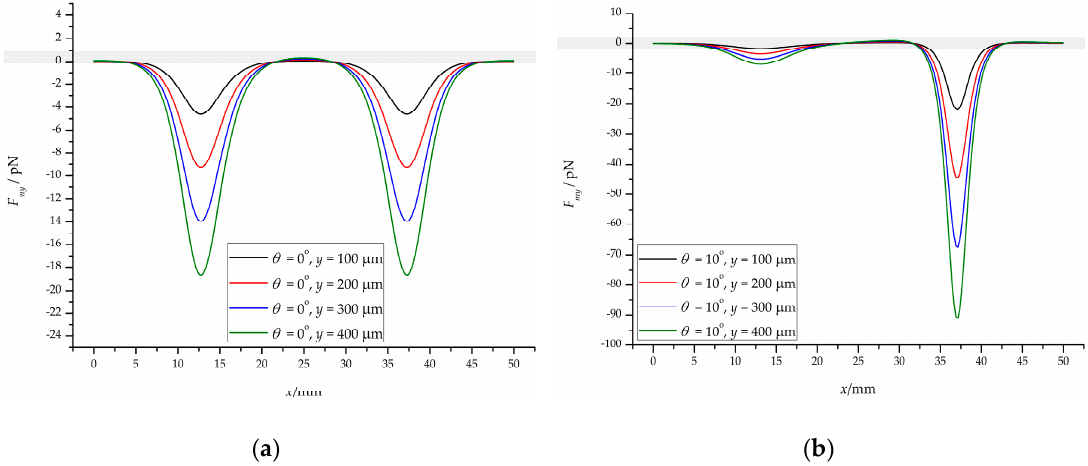
Figure 7. The results of magnetic force in the y -direction (half channel): ( a ) the vertical magnetic field; ( b ) the inclined magnetic field.